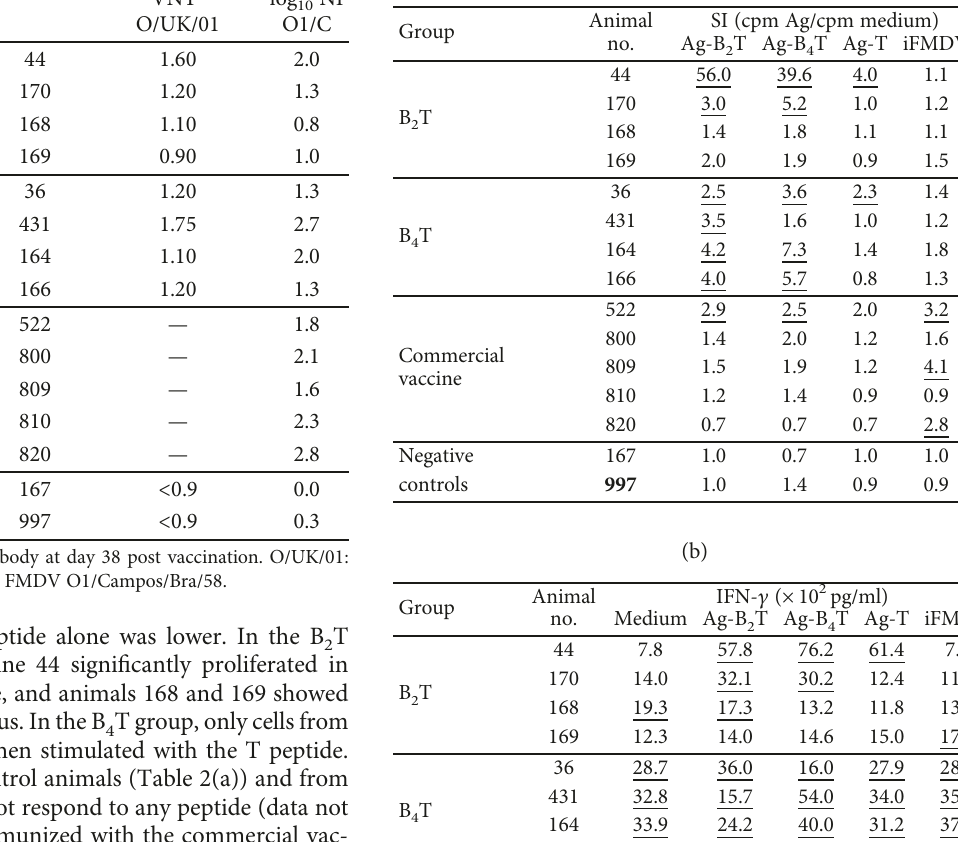
Table 1: Virus neutralizing titres prechallenge. Group Animal no.